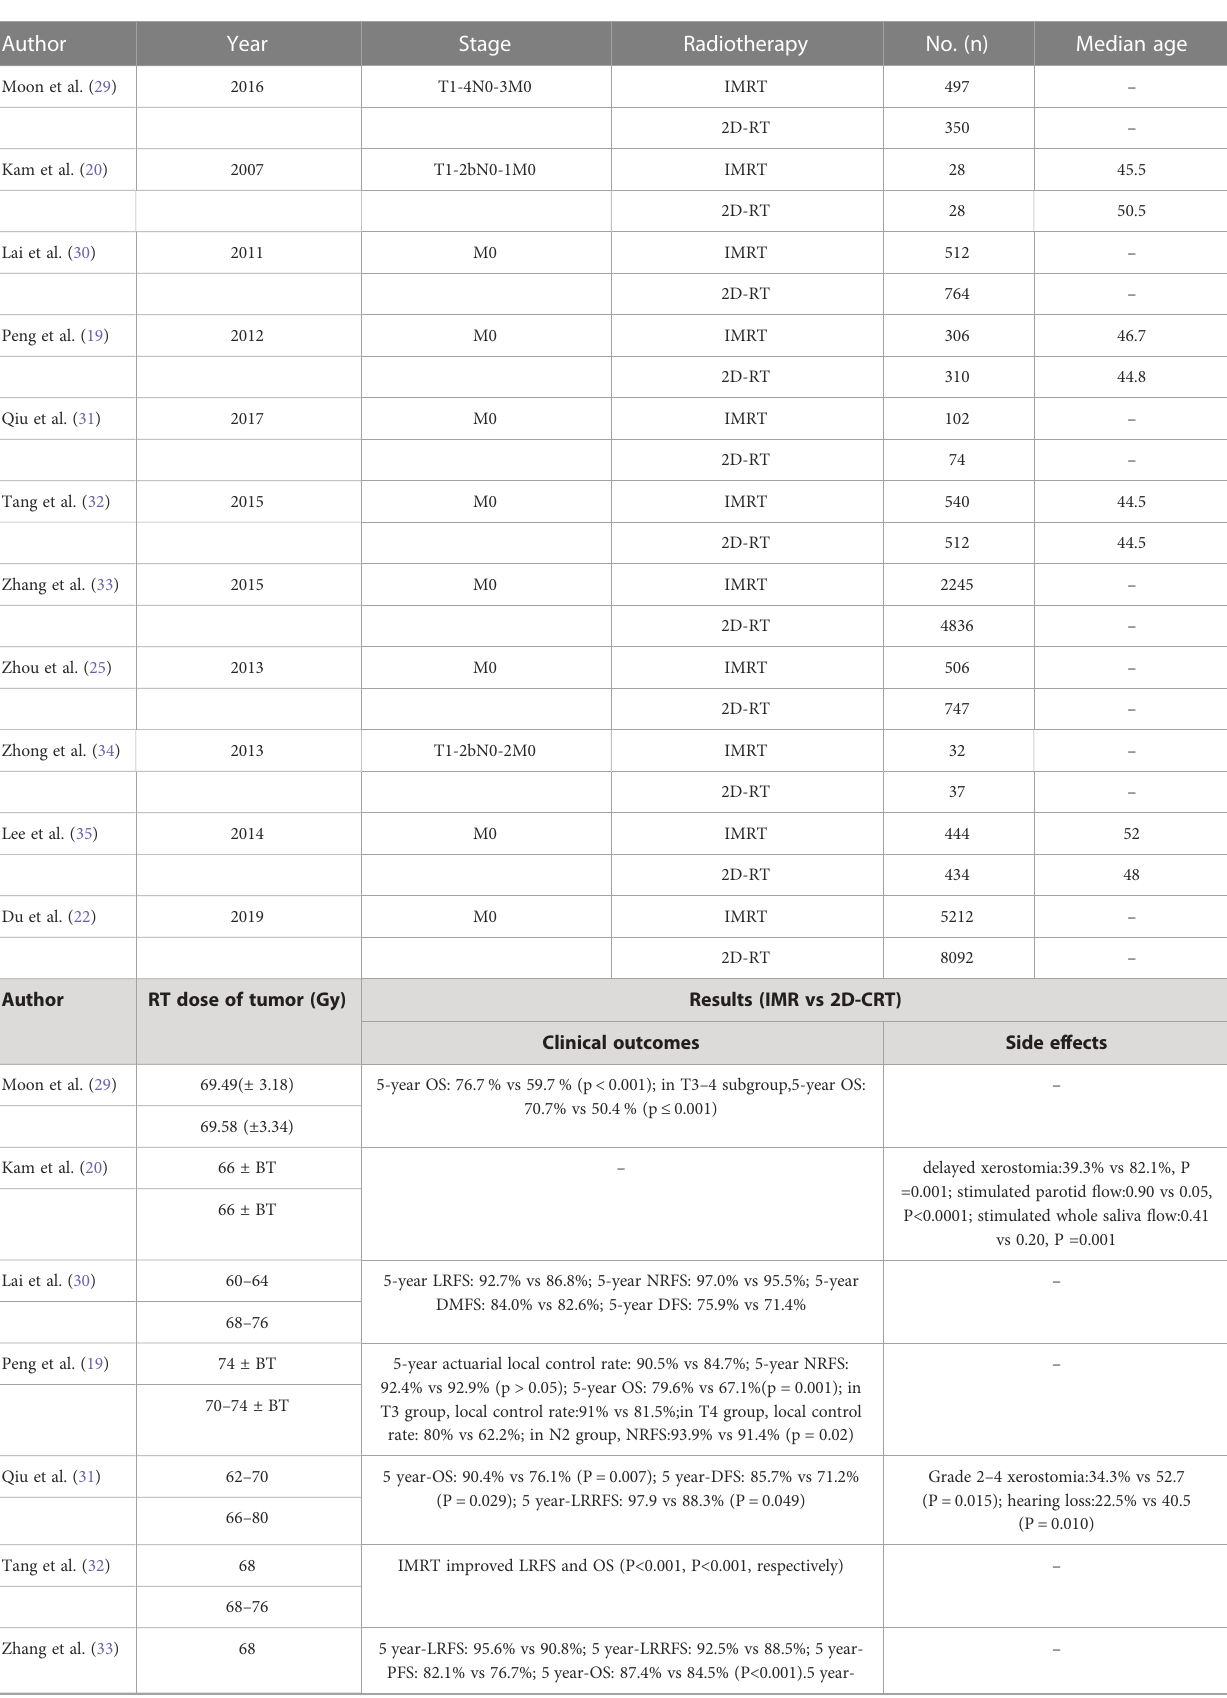
TABLE 1 The clinical data on IMRT ty 40versus 2D-CRT